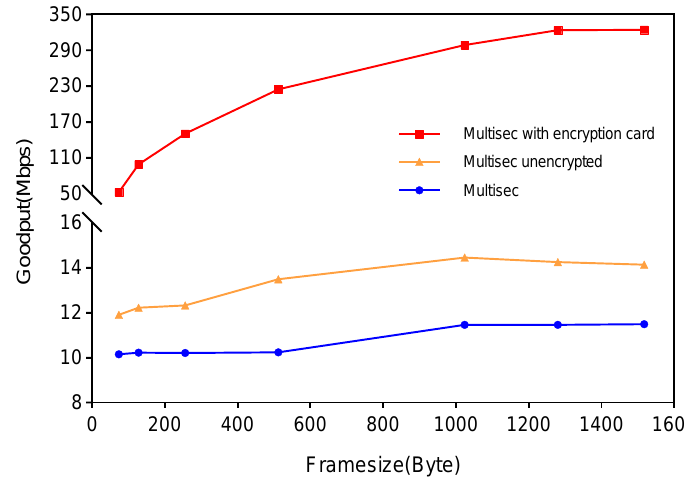
Figure 13. TCP Goodput evaluation.